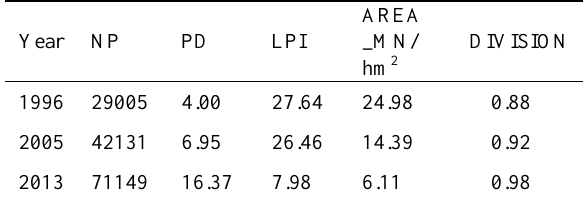
Table7 Landscape shape pattern index of Hangzhou Bay